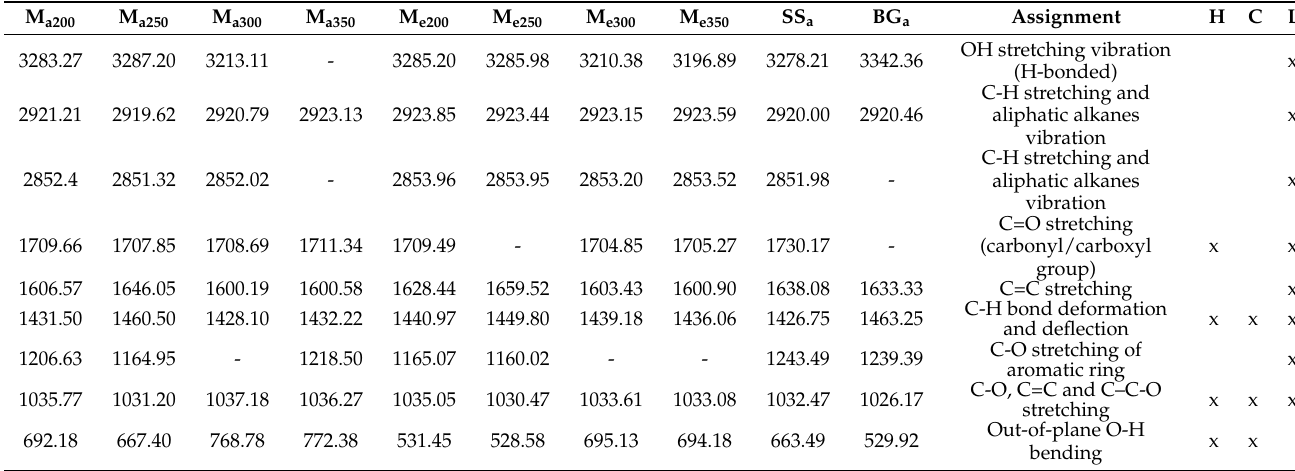
Table 3. Fourier-transform infrared spectroscopy (FTIR) peaks and their corresponding functional groups for torrefied sewage sludge and sugarcane